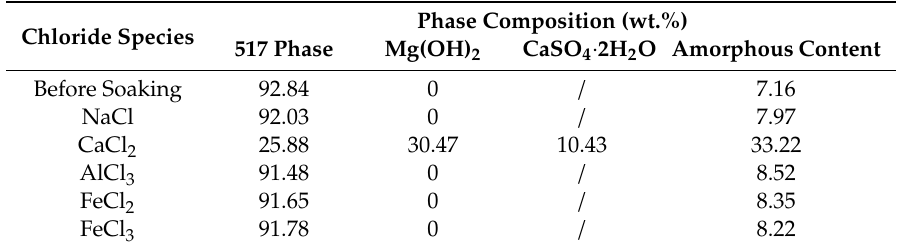
Table 1. Contents of hardened paste of 517 phase after immersion in different chloride solutions for 28 days.